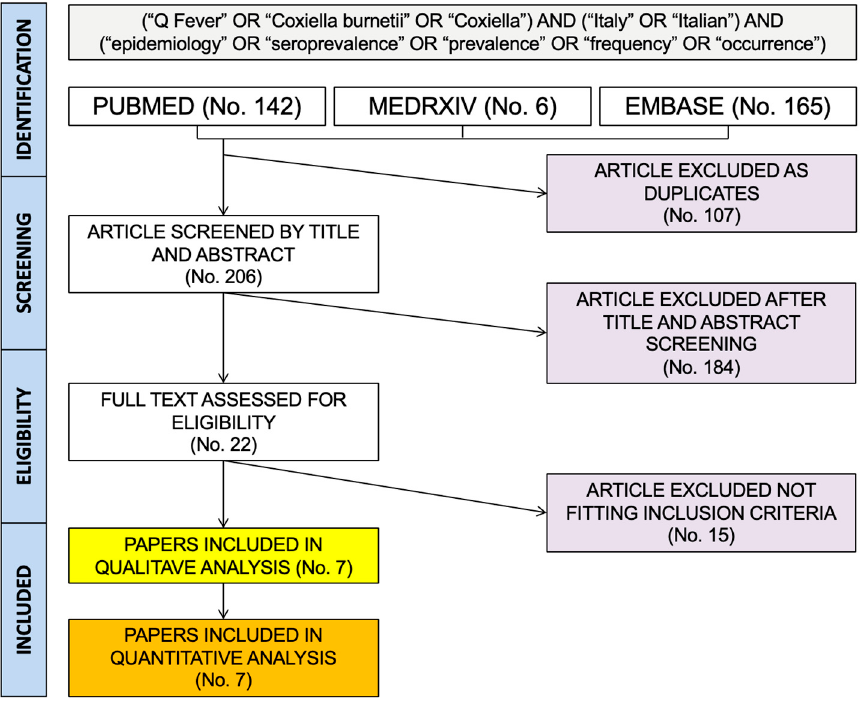
Figure 1. Flow chart of included studies.